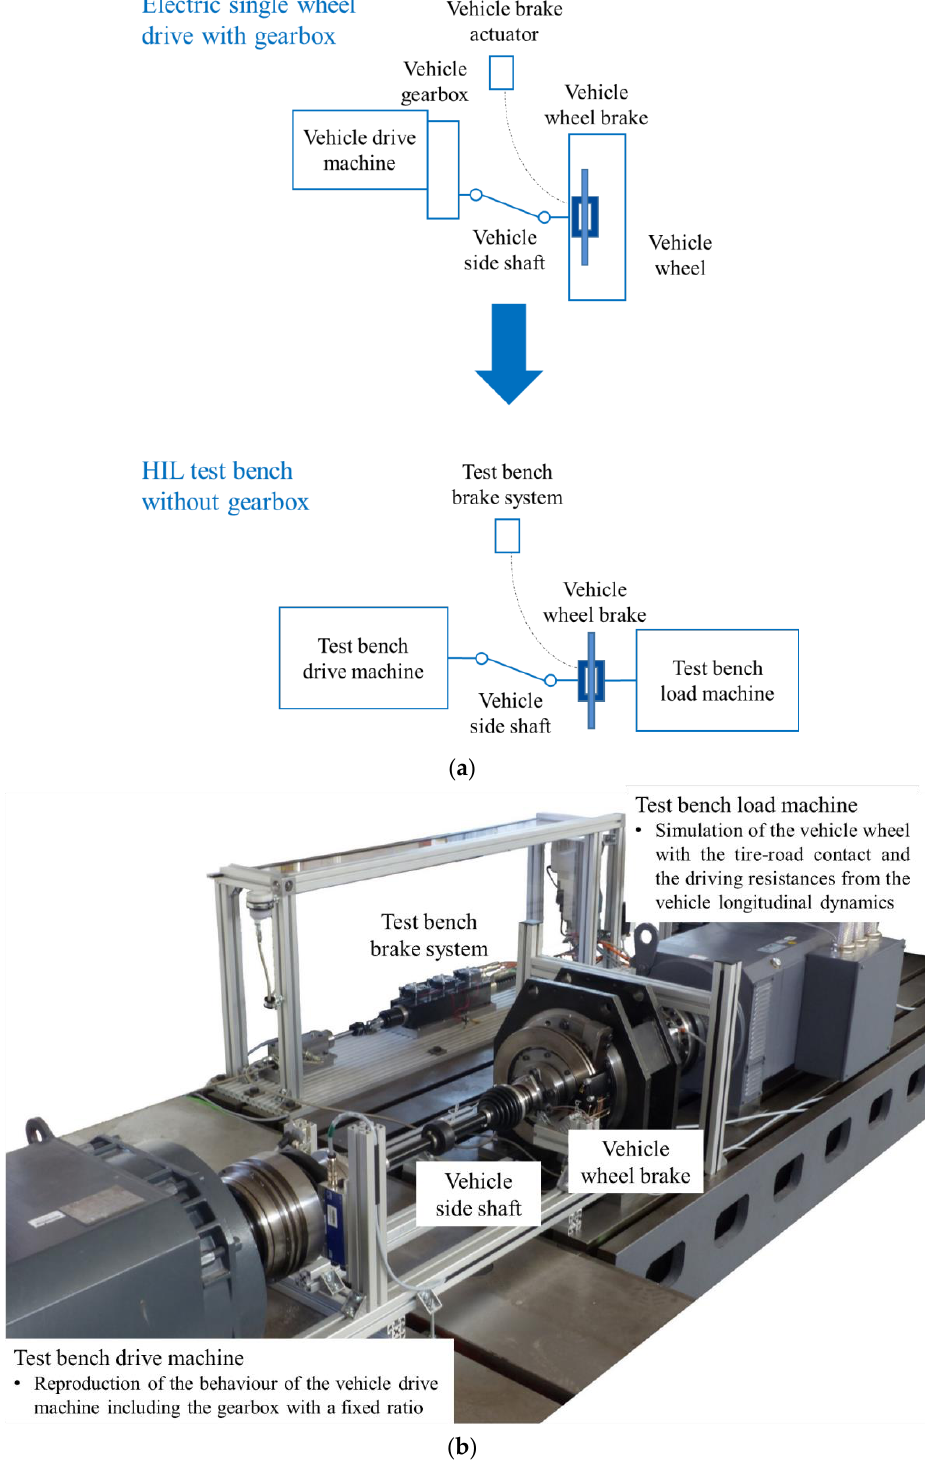
Figure 3. HiL test bench to reproduce an electric single-wheel drive. ( a ) Schema of an electric single-wheel drive with gearbox and HiL test bench without gearbox. ( b ) Structure of the HiL test bench.